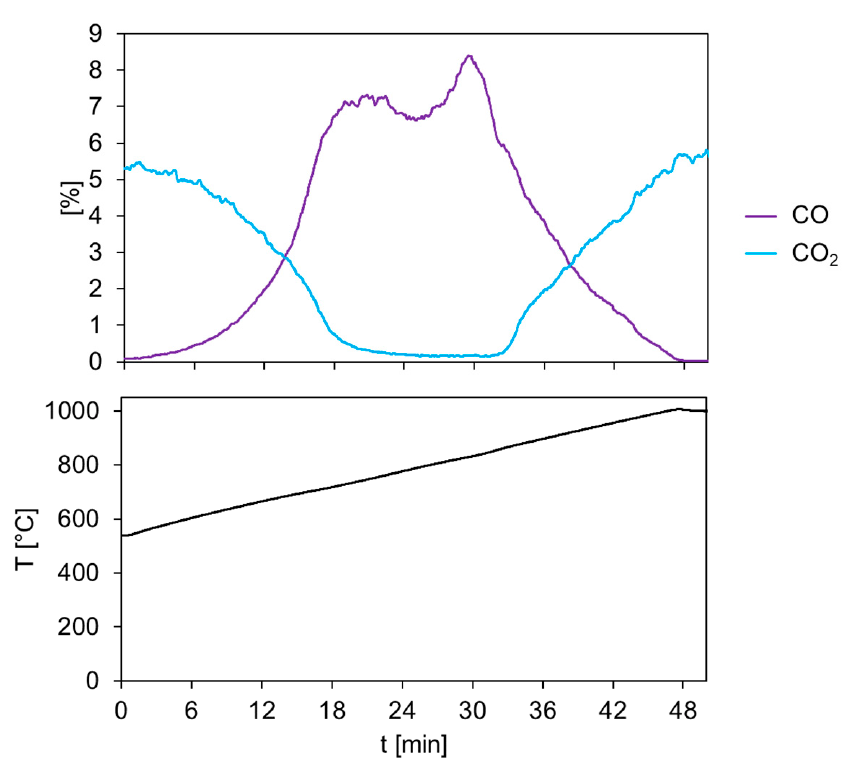
Figure 4. Temperature-Programmed Oxidation with 5% CO 2 in fixed-bed conditions.